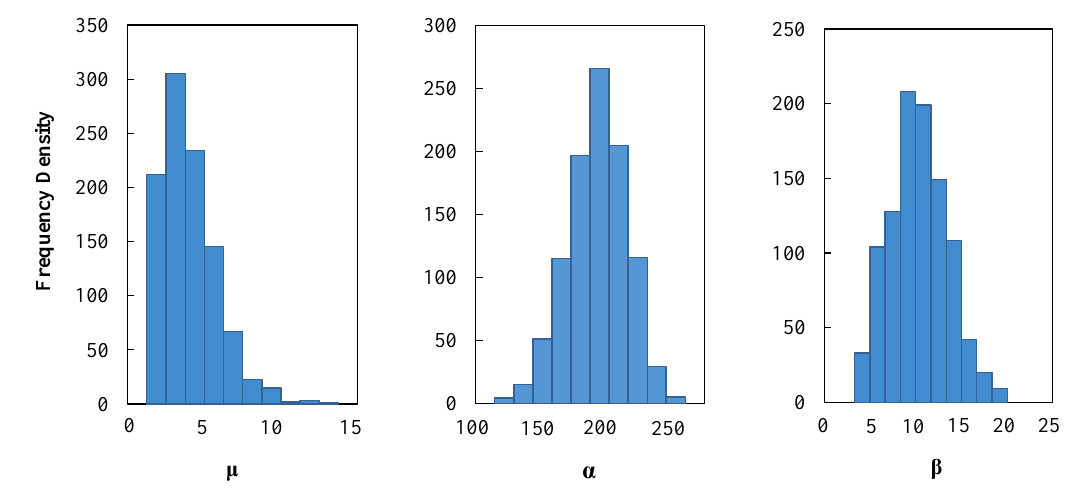
Figure 4. Histogram of bootstrap samples of the model